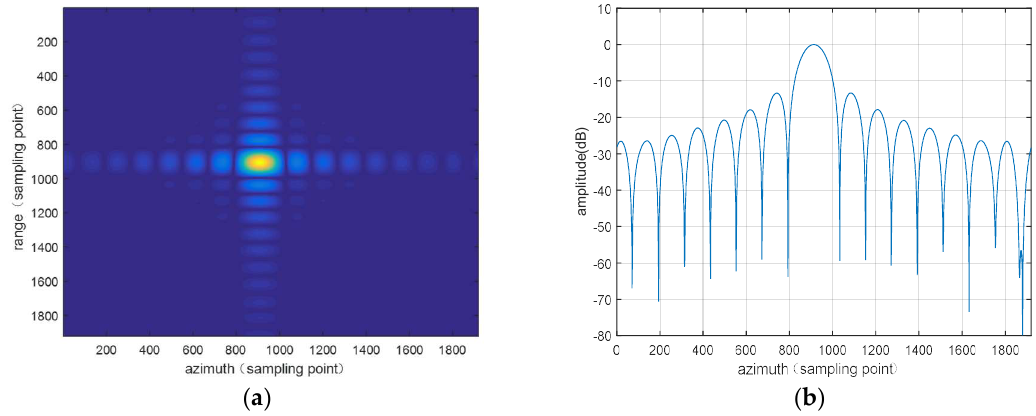
Figure 15. The simulation results for 6° bistatic angle without the consideration of the TCR optimum boresight. ( a ) The point target image after upsampling 48 times; ( b ) the azimuth profile based on the results of the electromagnetic simulation.